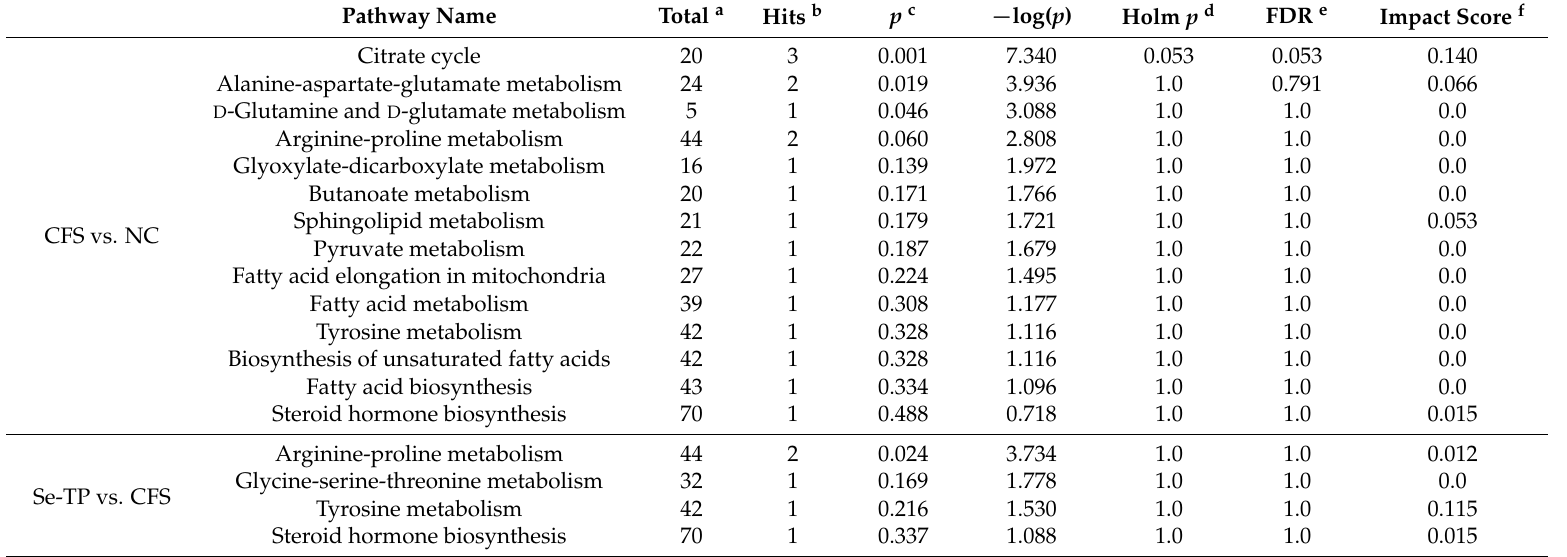
Table 5. Comparative results for the related metabolic pathways in CFS vs. NC and Se-TP vs.